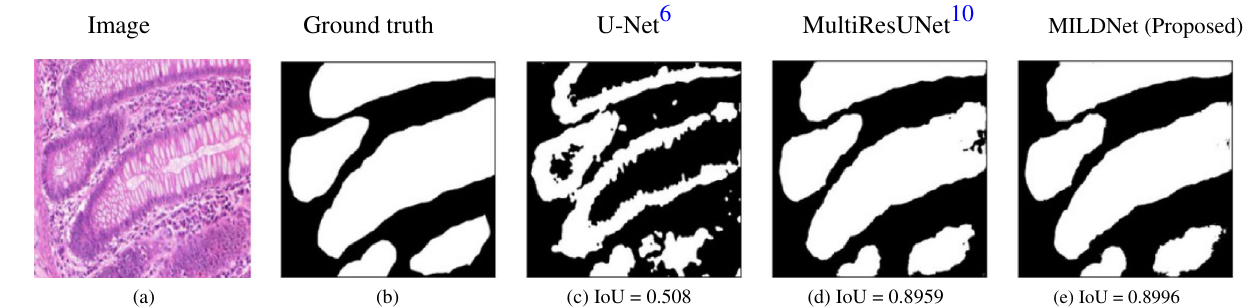
Figure 10. Segmenting a histopathology 16 image (a) and the ground truth mask (b) , in which the foreground is not consistent all around. The same staining color intensity and textures in the tumor (ROI) appear also in some non-tumor regions (background). The MILDNet approach (e) is consistently better in segmenting this challenging image than the classical U-Net (c) and the MultiResUNet (d) approaches.